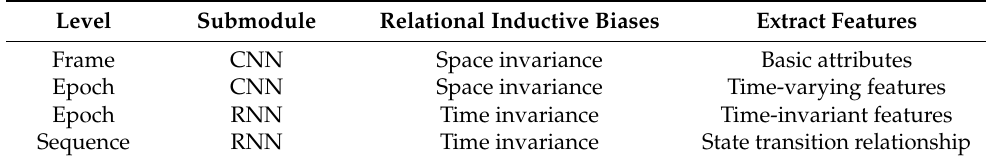
Table 7. Relational inductive biases of CCRRSleepNet